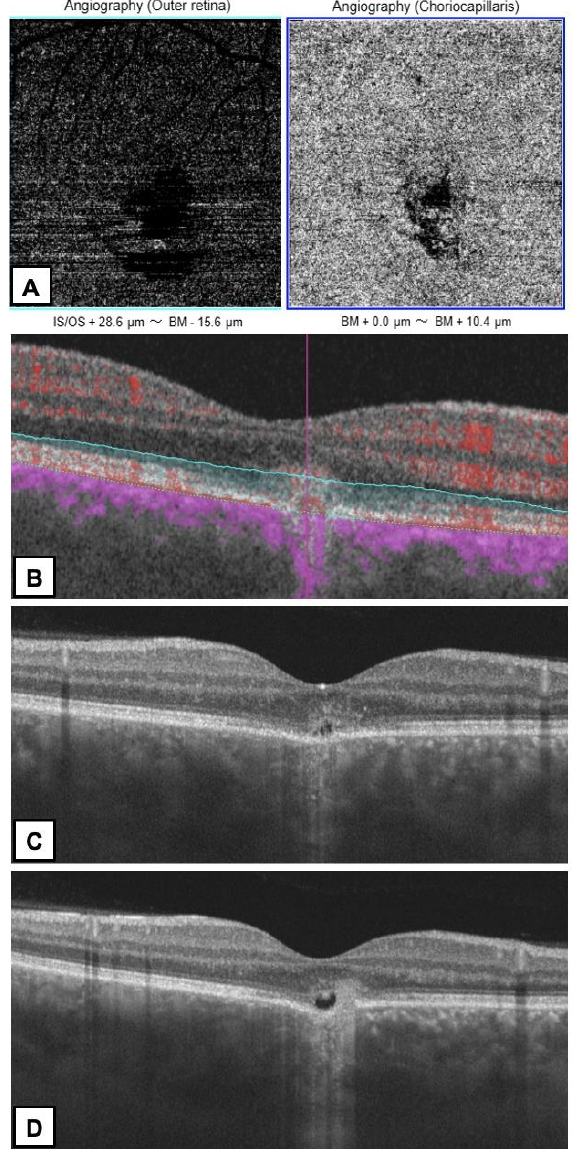
Figure 4. A 27-year-old woman with MNV complicating FCE type 2 in the right eye. ( A ) OCTA — small neovascular network visible in the outer retina and choriocapillaris layers with an adjacent dark halo. ( B ) The corresponding B-scan with adjusted segmentation boundaries and flow overlay reveals flow signal in the MNV ( C , D ) OCT B-scans — non-conforming FCE with disruption of the outer retinal layers by MNV.